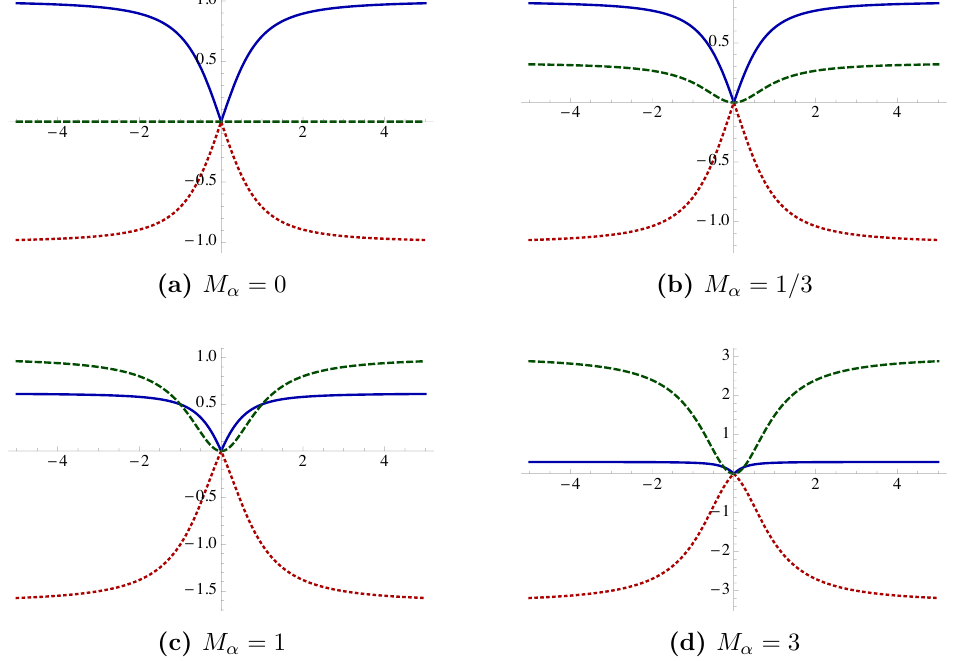
Figure 7. Brane embeddings of the form (4.10) for di(cid:11)erent values of M (cid:11) . In all the plots we have (cid:12)xed M (cid:12) =